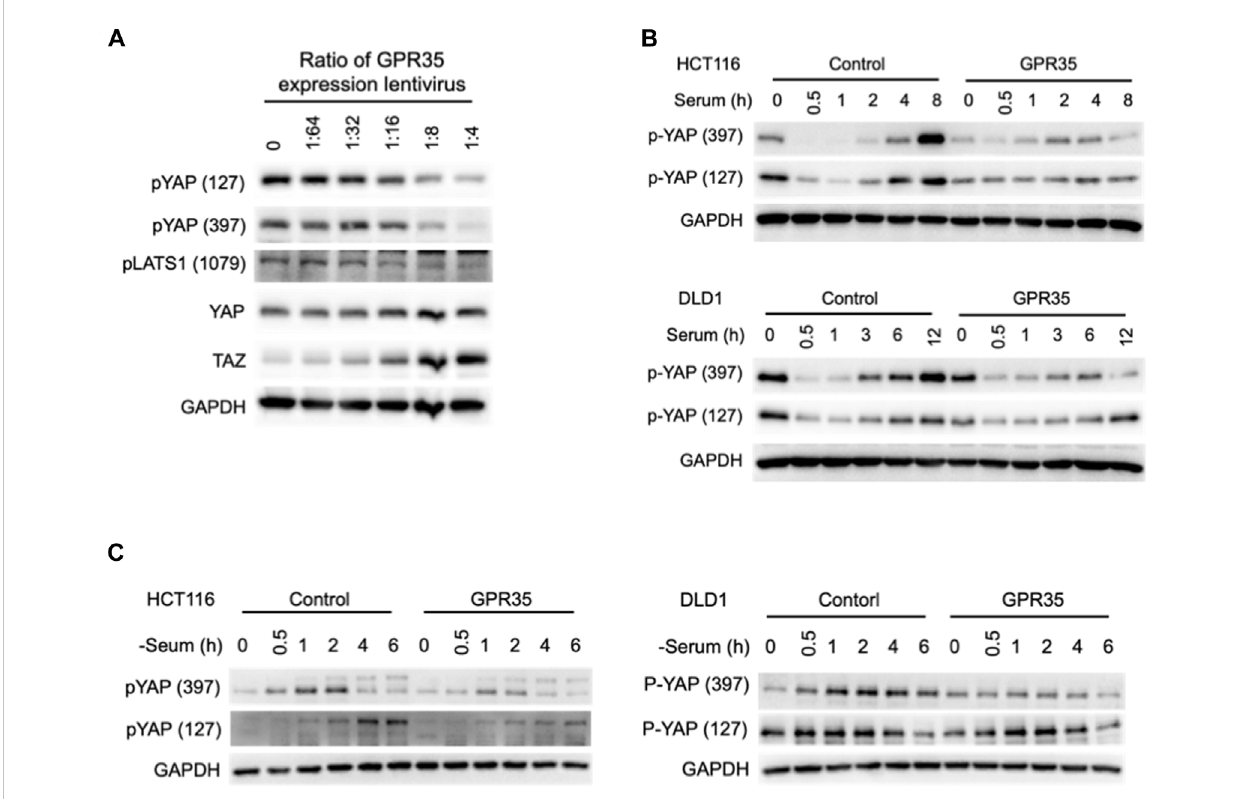
FIGURE 4 GPR35 expression moderated YAP/TAZ phosphorylation. (A) Western blot assay on YAP, TAZ, phosphorylated YAP, TAZ, and LATS1 after the indicated treatments. 293FT cells harvest for the assay after 48 h of incubation with different concentrations of GPR35 expression lentivirus. (B) Western blot analysis of phosphorylated YAP. After 24 h of culture, cells were subject to fresh medium containing 10% FBS. Cells were harvested at indicated time points; (C) Western blot assay on phosphorylated YAP after serum deprivation. After 24 h of culture, the medium was replaced by fresh serum-free medium and incubated for the indicated